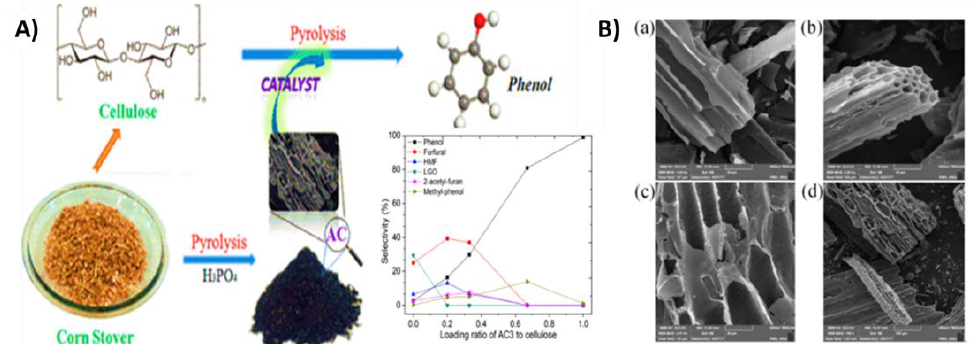
Figure 28. ( A ) Schematic representation of fabrication of the activated carbons (ACs) enriched in P-containing functional groups from corn stover. ( B ) SEM images of corn-stover-derived activated carbons, AC1 ( a ), AC2 ( b ), AC3 ( c ), and AC4 ( d ). Adapted with permission from ref. [136].